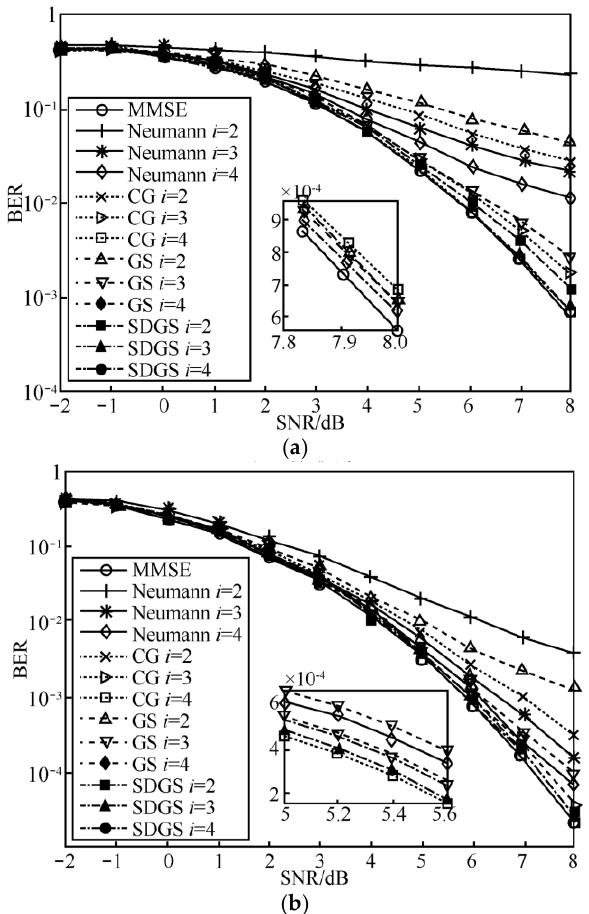
Figure 3. Soft decision bit error rate (BER) performance comparison. ( a ) Analysis at 64 × 16 antenna configuration; ( b ) Analysis at 128 × 16 antenna configuration.